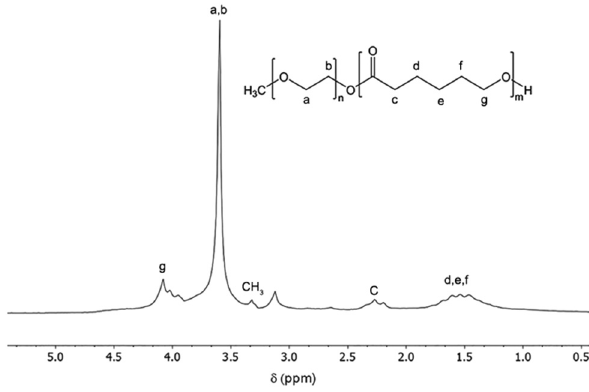
Figure 3: 1 H NMR spectrum of the mPEG - PCL block